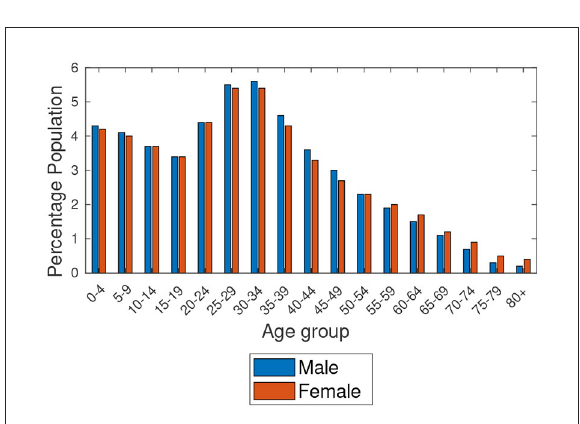
FIGURE2 Age structures of the population’s of Gauteng (South Africa).